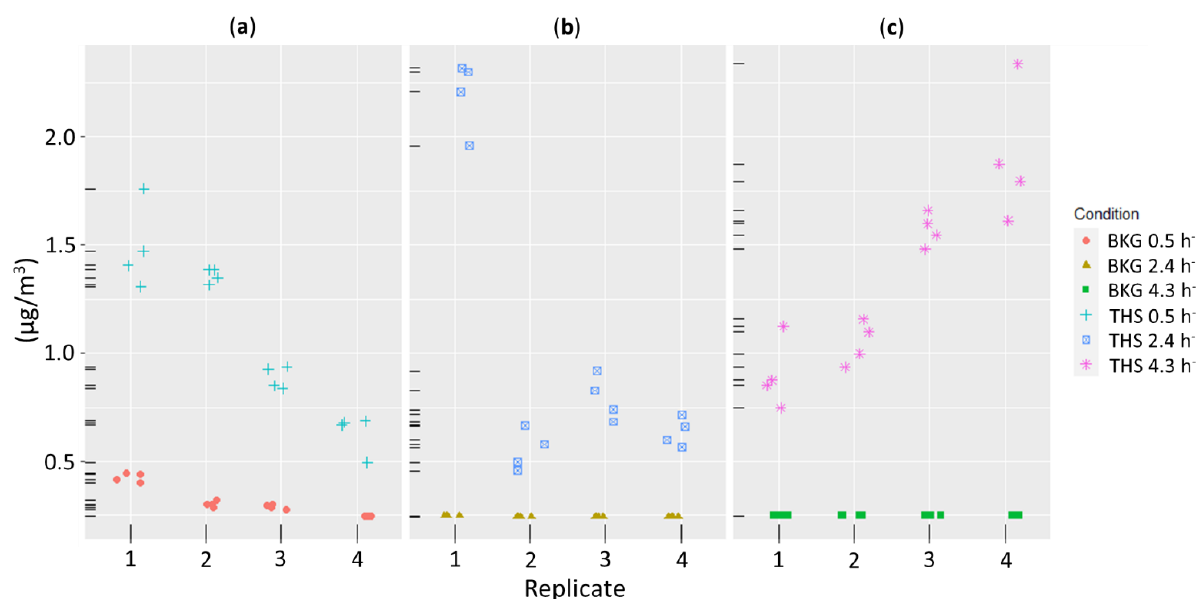
Figure 1. Comparison of the concentrations of airborne nicotine ( µ g/m 3 ) in the background (BKG) and THS 2.2 use sessions (THS) under simulated ( a ) Residential category III (0.5 h − 1 ), ( b ) Store (2.4 h − 1 ), and ( c ) Restaurant (4.3 h − 1 ) environments. Table 1. Summary of mean concentrations of airborne constituents measured offline in the background and THS 2.2 environmental aerosol under simulated Residential category III (0.5 air changes/h), Store (2.4 air changes/h), and Restaurant environmental conditions (4.3 air